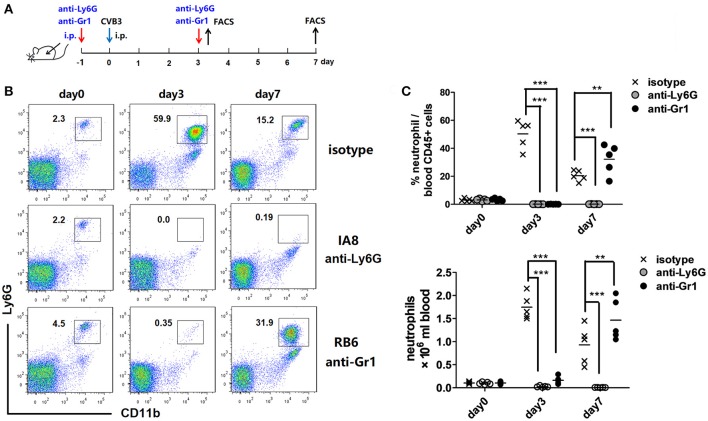
Neutrophil depletion efficiency. (A) Study design. BALB/c mice were treated i.p. with isotype matched IgG, anti-Ly6G(1A8, 12.5 mg/Kg) or anti-Gr-1(RB6-8C5, 10 mg/Kg) Abs on day −1 and 3, and subjected to CVB3 i.p. infection on day 0. Peripheral neutrophil counts were enumerated by flow cytometry. (B) Representative flow cytometry dot plots of CD45+ cells in peripheral blood leukocytes at 3 and 7 dpi. Time course depicting proportion of CD11b +Ly6G+ neutrophils against CD45+population in the blood from 0 to 7 dpi. (C) Time course depicting total numbers of Ly6G+ neutrophils in blood from 0 to 7 dpi. Data pooled from three independent experiments, n ≥6 mice per group. Results are presented as mean ± SEM. **p < 0.01; ***p < 0.001.